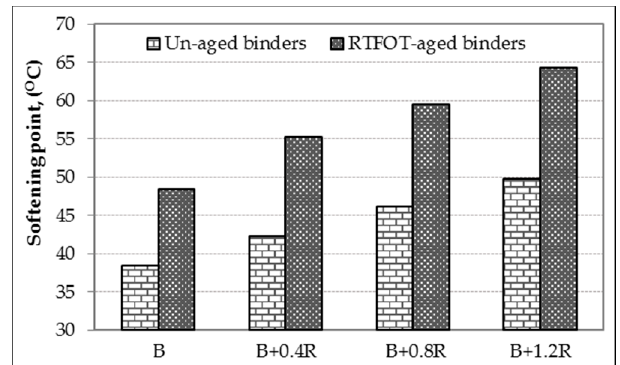
Figure 8. The softening point changing of binders.